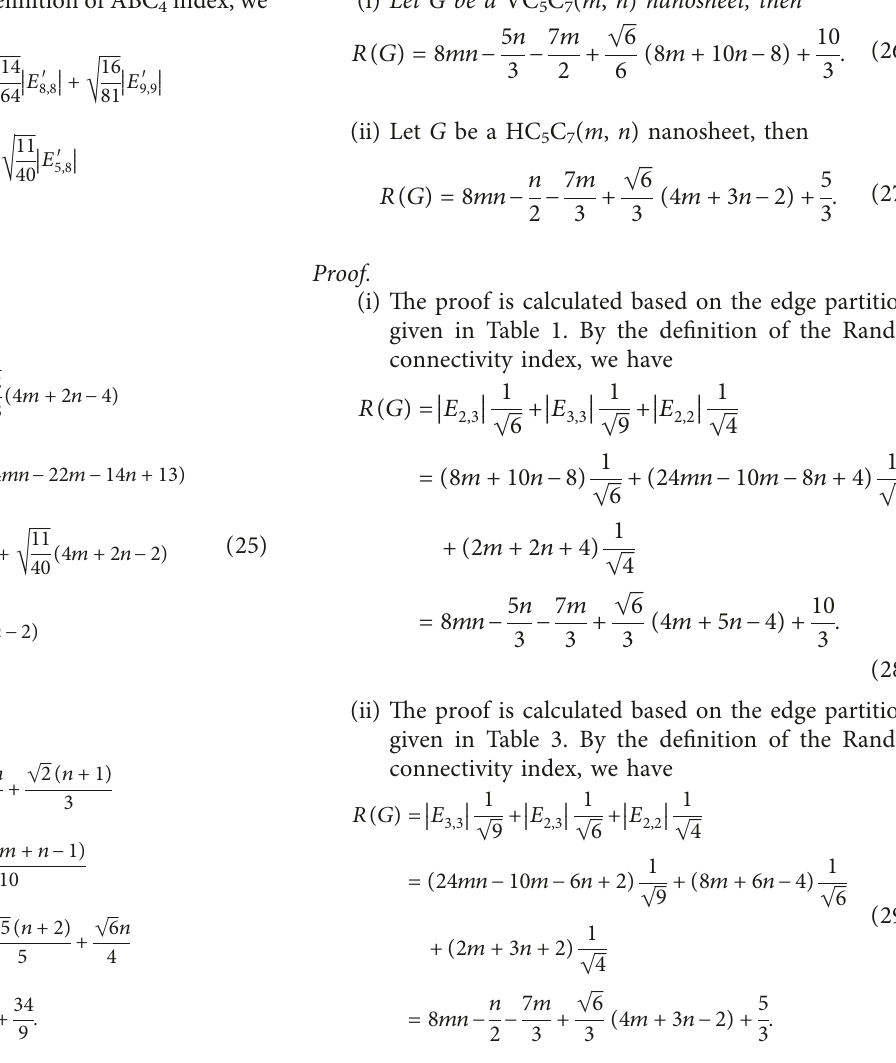
5 C 7 (2, 4) by different